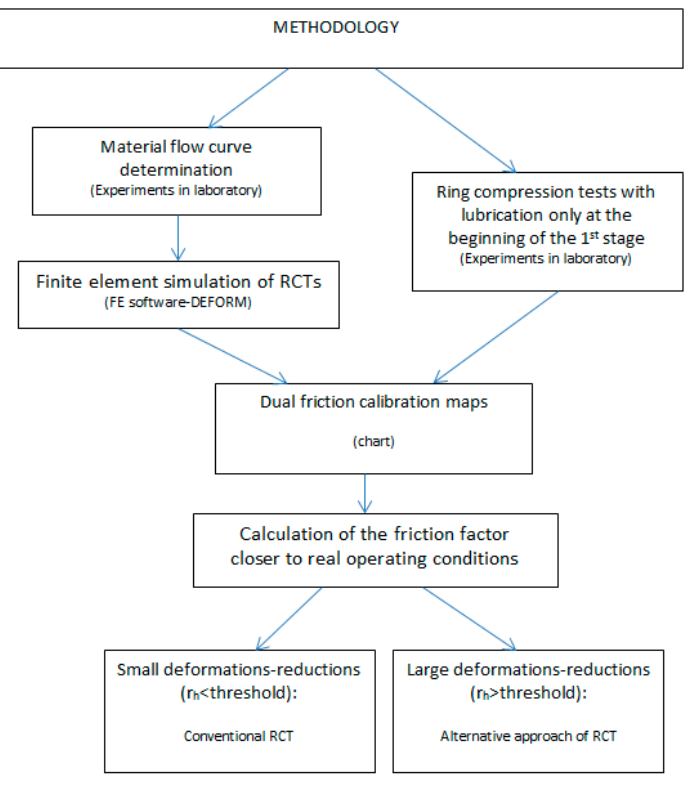
Figure 1. Outline of the methodology. RCT refers to ring compression test.